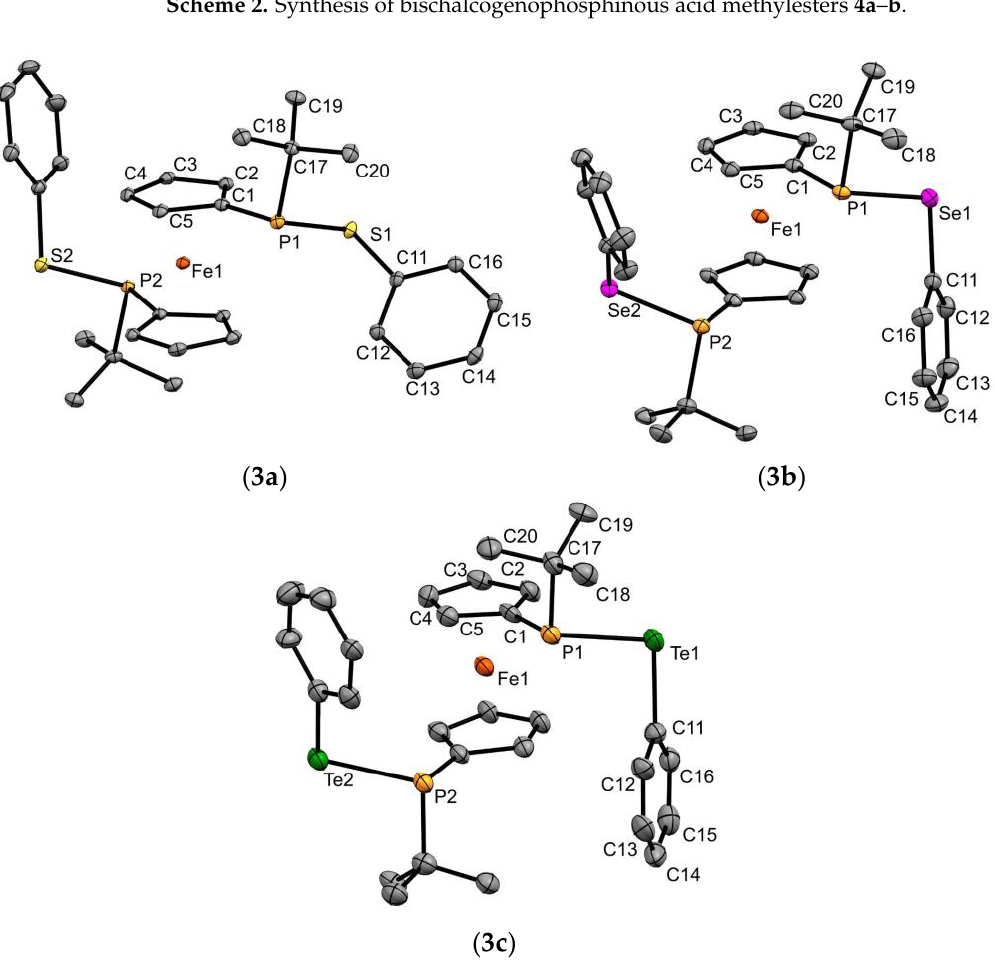
Figure 1. Molecular structure of 3a (top left), 3b (top right), and 3c (bottom) in solid state. Ellipsoids are shown at 30% probability, and all hydrogen atoms have been omitted for better overview. For 3a , two molecules were found within the unit cell from which one is depicted. Selected bond lengths and angles of 3a : S1-P1 2.1236(8) Å, S2-P2 2.1292(8) Å, Σ P1 = 301.28(8) ◦ , Σ P2 = 303.70(8) ◦ ; 3b : Se1-P1 2.2595(11) Å, Se2-P2 2.2599(9) Å, Σ P1 = 304.70(14) ◦ , Σ P2 = 303.92(13) ◦ ; and 3c : Te1-P1 2.4660(2) Å, Te2-P2 2.4880(3) Å, Σ P1 = 305.80(4) ◦ , Σ P2 = 306.90(4) ◦